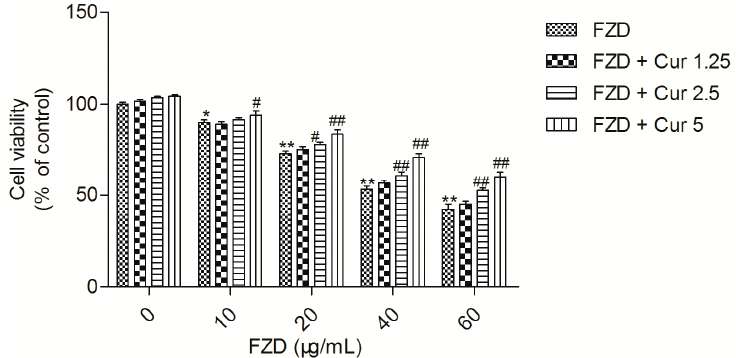
Figure 1. Curcumin protects against FZD induced cytotoxicity in L02 cells. Values were presented as mean ± SD, from five independent experiments. * p < 0.05, ** p < 0.01, compared to the negative control group (0.2% DMSO); # p < 0.05, ## p < 0.01, compared to the FZD alone group. FZD, furazolidone.